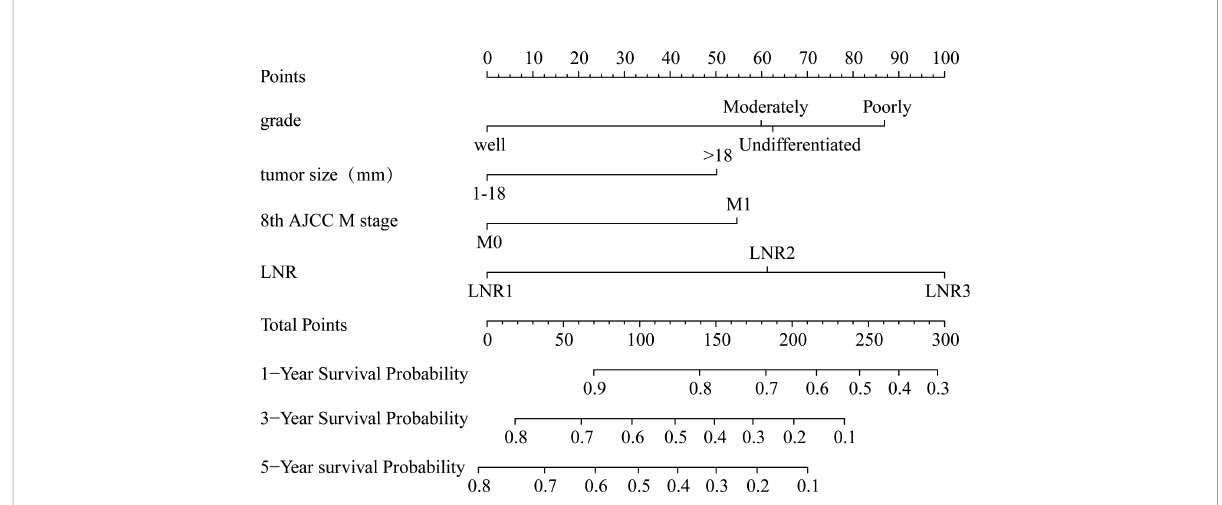
FIGURE 2 Nomogram for predicting the 1-, 3- and 5-year probabilities of cancer-speci fi c survival in surgically treated early-onset pancreatic cancer patients in the training cohort. The nomogram was constructed by grade, tumor size, 8th AJCC M stage, and LNR. LNR, lymph node ratio; AJCC, American Joint Committee on